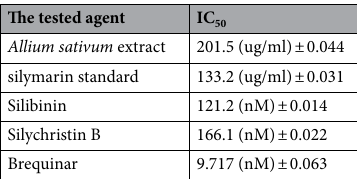
Table 3. In vitro hDHODH inhibitory activity of the tested agents. *Data are demonstrated as mean of two tests ± SD.